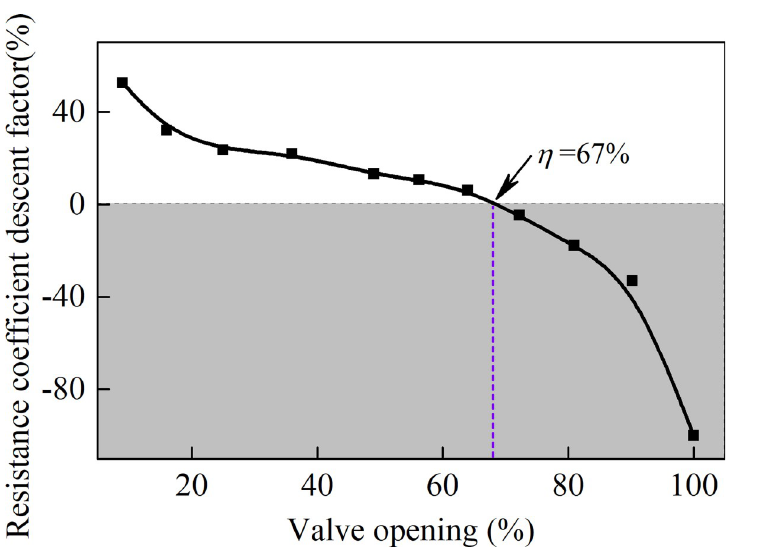
Fig 8. Resistance coefficient descent factor at different valve openings.